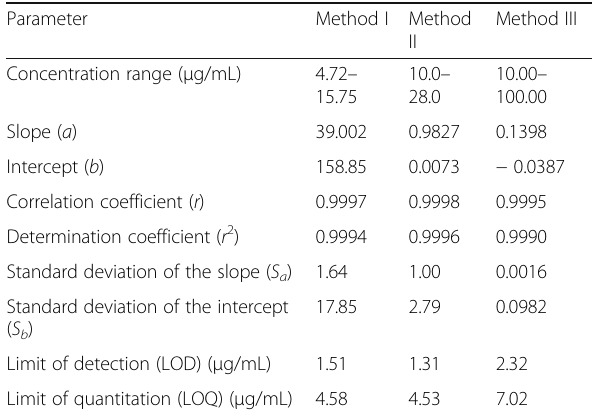
Table 3 Analytical parameters for the analysis of Tenofovir by the purposed spectrofluorimetric, first derivative spectrophotometric, and HPLC methods